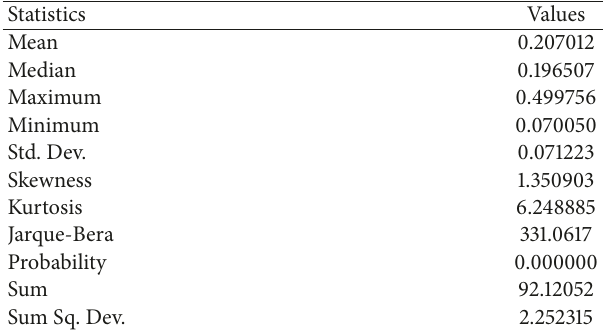
Figure 9: [𝑚 − 10, 𝑚 + 10] confidence interval.